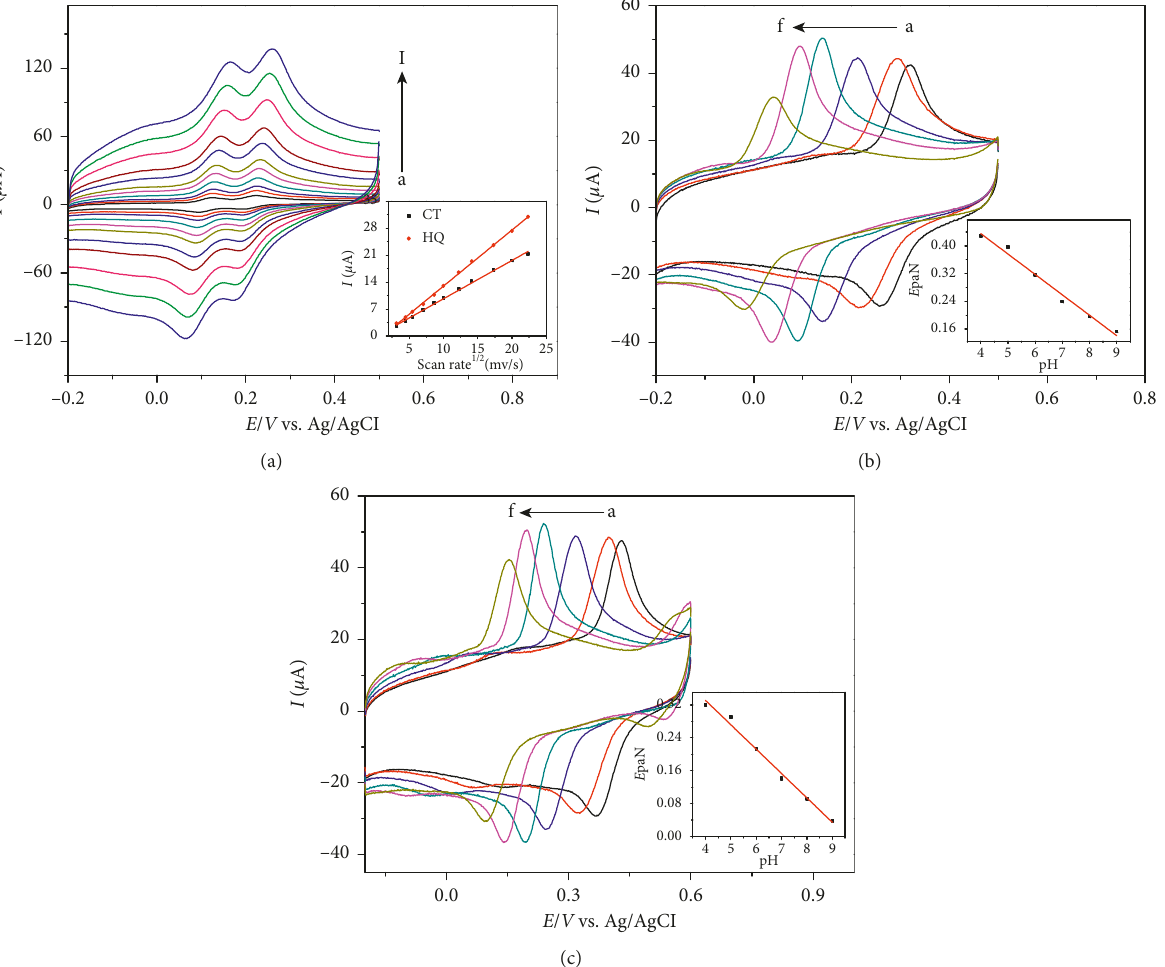
Figure 5: (a) CVsforthemixture solutionofHQandCT(0.5mMeach) inPBS(pH7.0) atPCH/AGCEwith differentscanrates( a ⟶ l:10,20,30, 40, 50, 75, 100, 150, 200, 300, 400, and 500mV/s). The inset shows a plot of I pa vs. the square root of the scan rate for HQ and CT. CVs of (b) CT (0.5mM) and (c) HQ (0.5mM) at the PCH/AGCE with different pH values ( a ⟶ f : 4, 5, 6, 7, 8, and 9) at a scan rate of 100mV/s. The inset shows plots of E pa vs. pH.